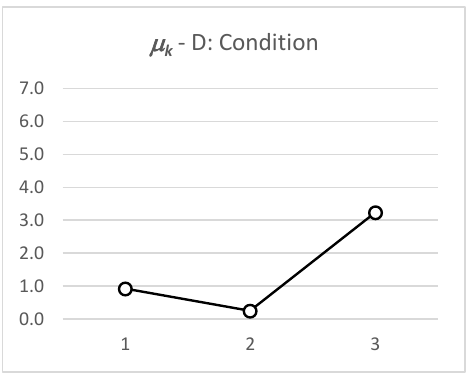
Figure 6. Factor D level effect on 